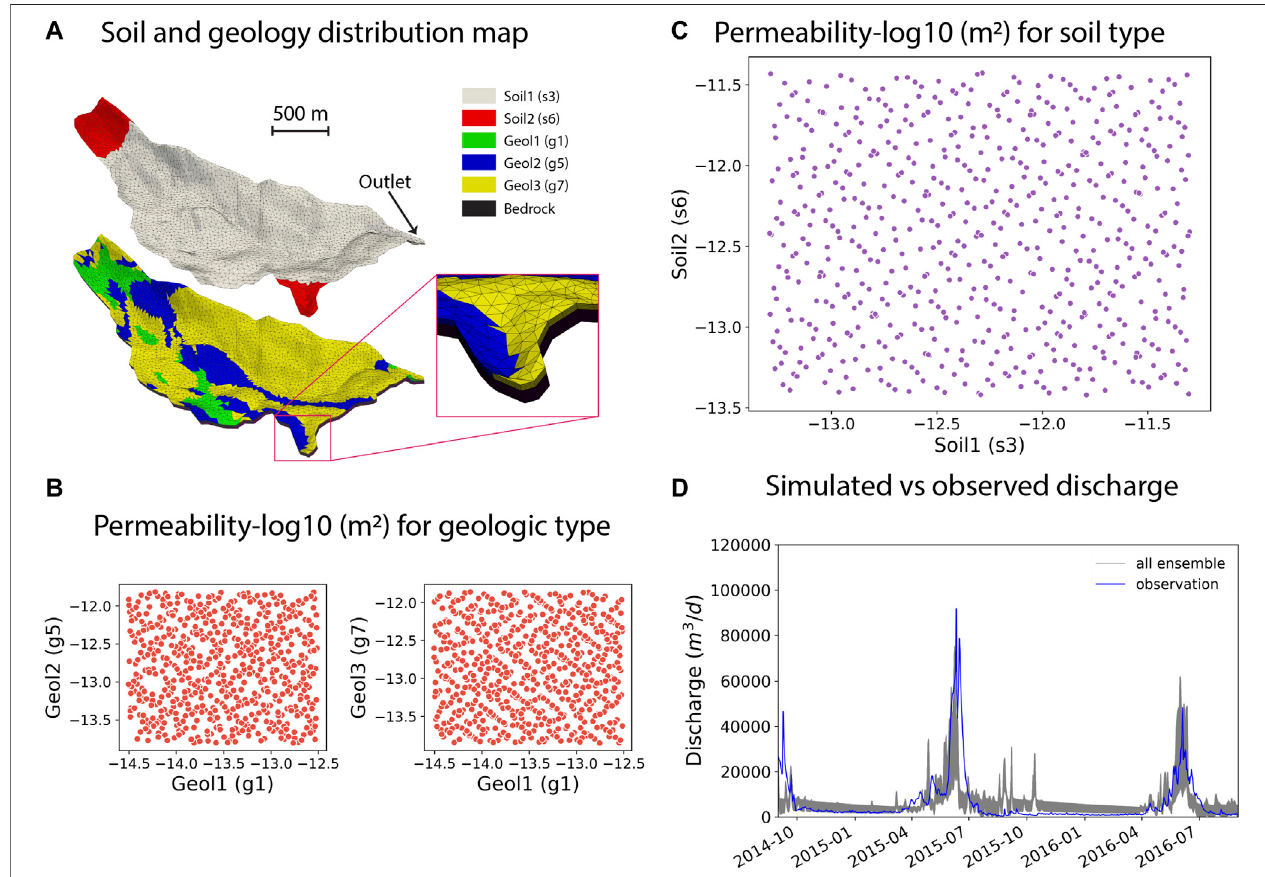
FIGURE 2 | (A) Soil and geology distribution within the Rock Creek watershed. The zoom-in box shows the triangle meshes. (B) Permeability [log10 (m 2 )] realizations for three geologic types. (C) Permeability [log10 (m 2 )] realizations for two soil types. (D) Ensemble of simulated discharge hydrographs from 597 realizations compared with the observed discharge